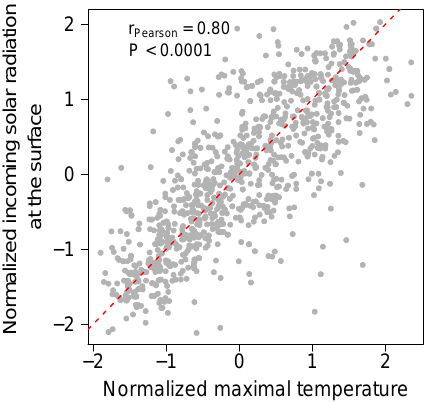
Figure 8. Association between normalized maximal temperature from Climate Research Unit and normalized incoming solar radi- ation at the surface from CERES. Monthly incoming solar radiation at the surface (incident shortwave radiation) refers to radiant energy with wavelengths in the visible, near-ultraviolet, and near-infrared spectra and is produced using MODIS data and geostationary satel- lite cloud properties (Kato et al., 2011). The red dashed line is the identity line y = x